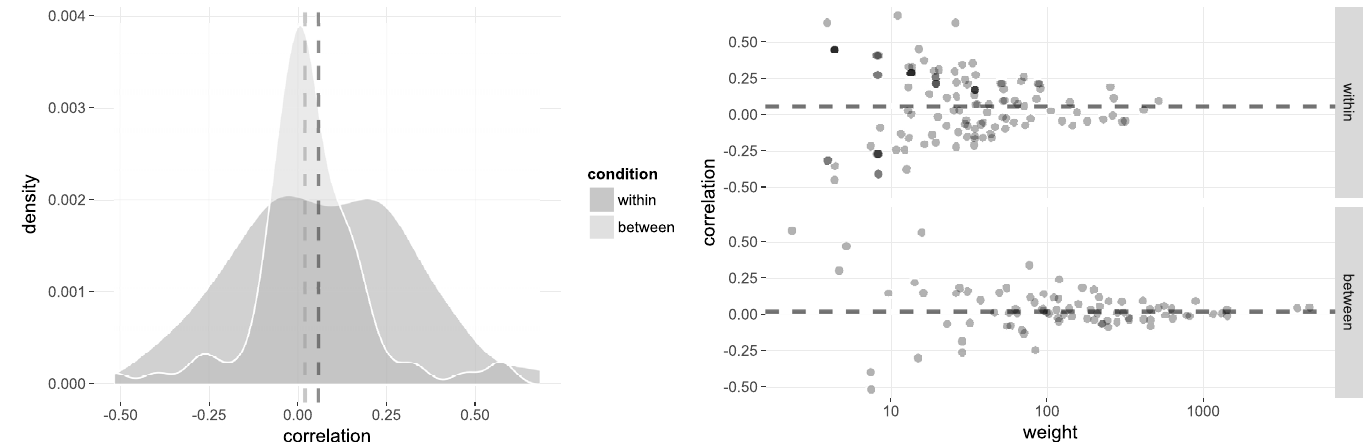
Fig 6. The left panel shows the distribution of correlation coefficients in each class (within) or programme/school combination (between). The right panel shows the coefficients plotted against their weights (on a log scale) in the meta-analysis. The dashed lines represent the weighted aggregated correlation coefficients from the meta-